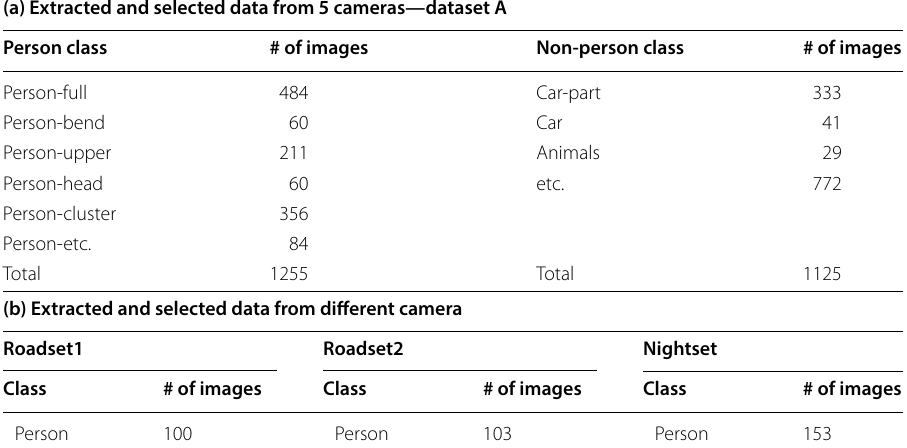
Table 2 Extracted and selected data after background subtraction (a) Extracted and selected data from 5 cameras—dataset A Person